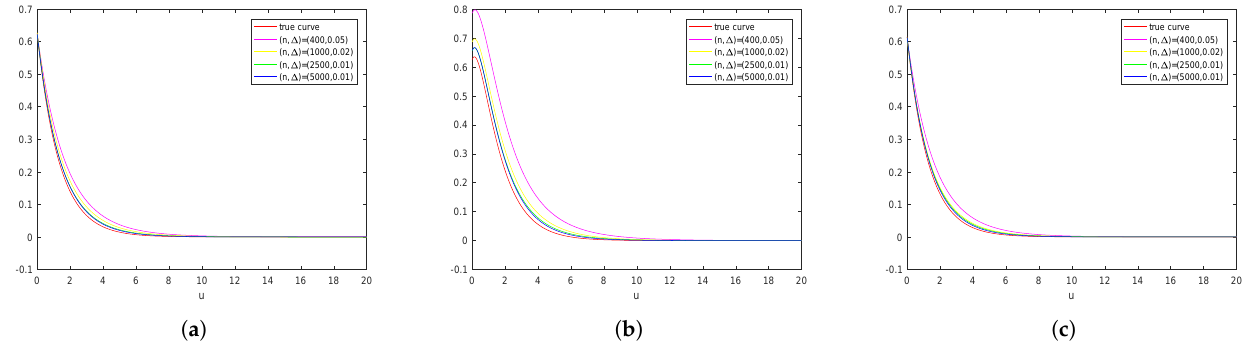
Figure 4. For the compound Poisson risk model, we estimate the Gerber–Shiu functions by mean value curves. ( a ) Ruin probability; ( b ) Expected claim size causing ruin; ( c ) Laplace transform of ruin